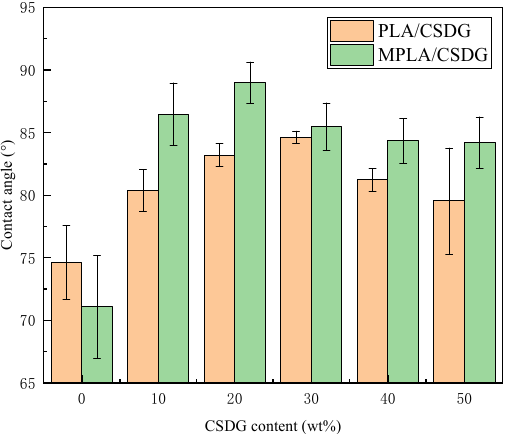
Figure 12. Contact angle of PLA/CSDG and MPLA/CSDG composites.